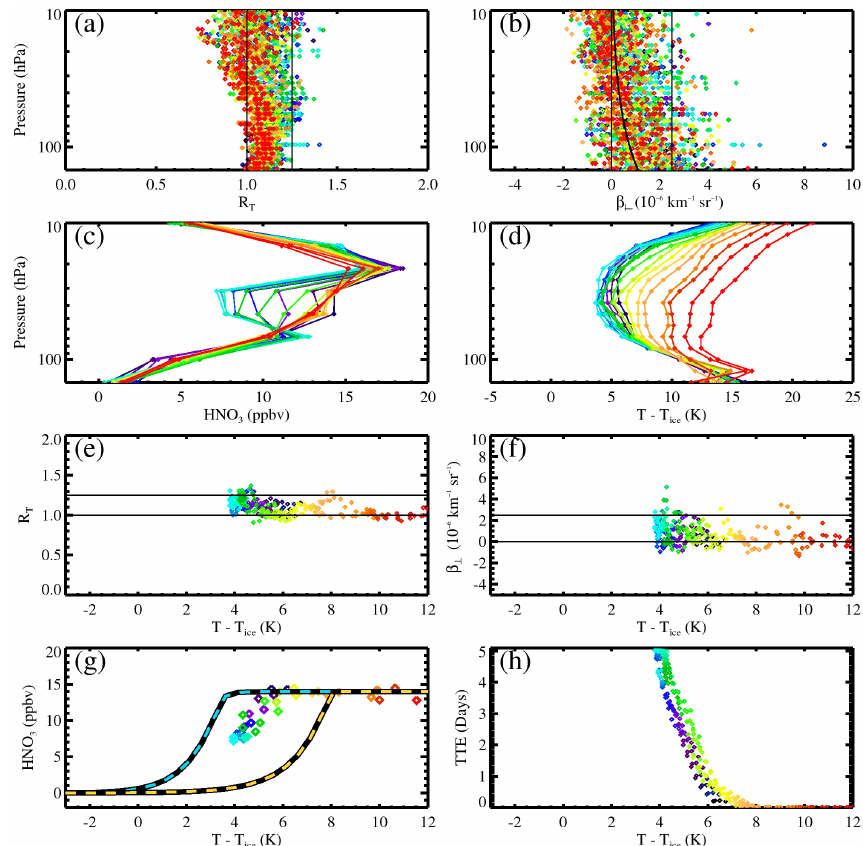
Fig. 8. Upper panels (a–d) : vertical profiles of (a) total backscatter ratio, (b) perpendicular backscatter coefficient, (c) MLS HNO 3 , (d) tem- perature relative to the frost-point ( T − T ICE ). Lower panels (e–g) : scatter plots against temperature relative to the frost-point for quantities on the combined 46 and 32hPa pressure surfaces, where (e–g) are for the same quantities shown in (a–c) . (h) Temperature threshold exposure (TTE) for T − T ICE < 5K (in days). Data are color coded according to their location along the orbit track given in Fig. 7. CALIOP data are shown without an imposed PSC classification and MLS data are shown in (c, g) at their original retrieved resolution without interpolation. Thin solid black lines indicate backscatter ratios of 1.0 and 1.25 in (a, e) and perpendicular backscatter values of 0 and 2 . 5 × 10 − 6 km − 1 sr − 1 in (b, f) , respectively. The curved line in (b) shows the calculated perpendicular backscatter arising from molecular scattering, which has been subtracted from the observed perpendicular backscatter. All temperatures and temperature differences are given in